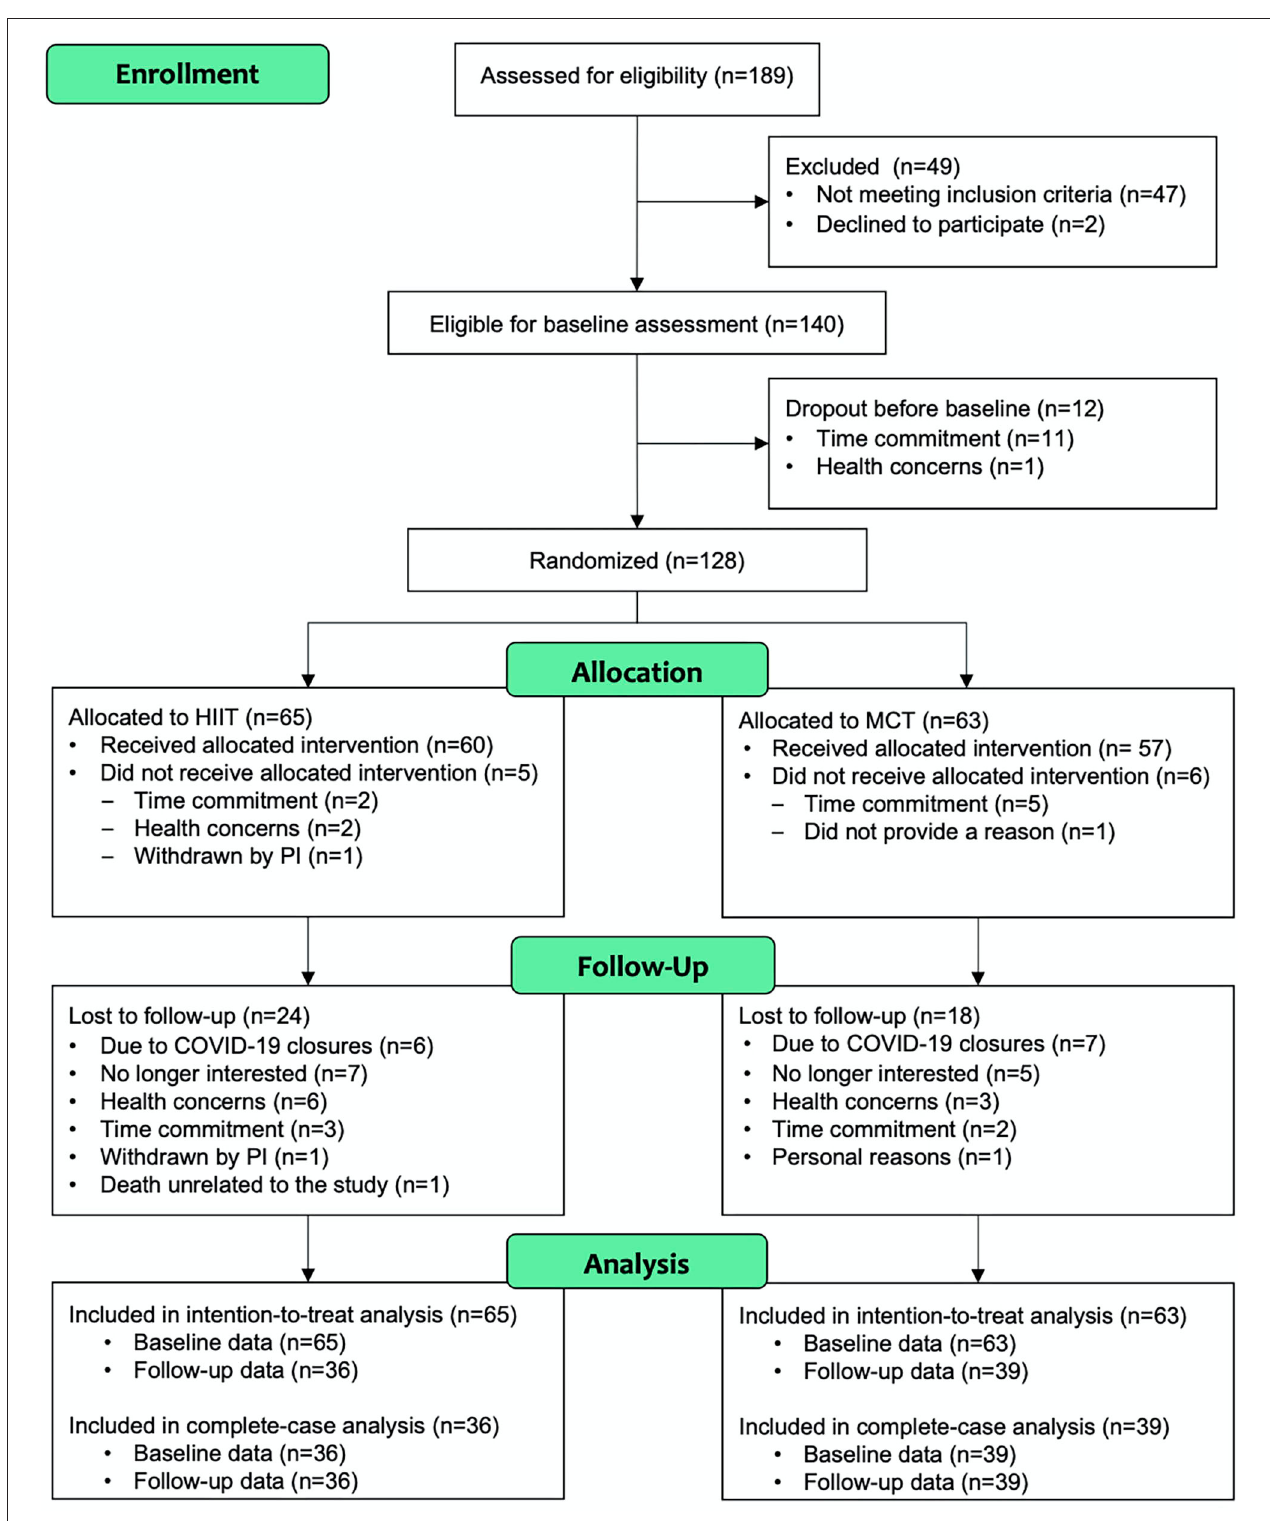
FIGURE 2 | Study CONSORT diagram to illustrate participant flow throughout the study.